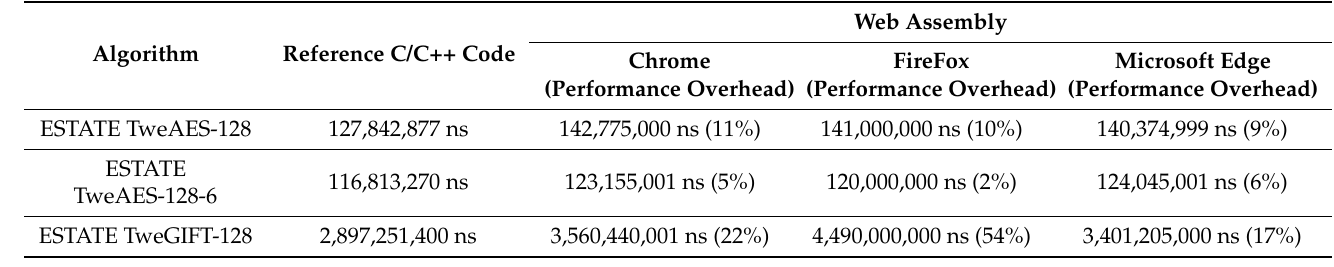
Table 10. Performance overhead measurement result of ESTATE algorithm using Web Assembly (ns: nanosecond).